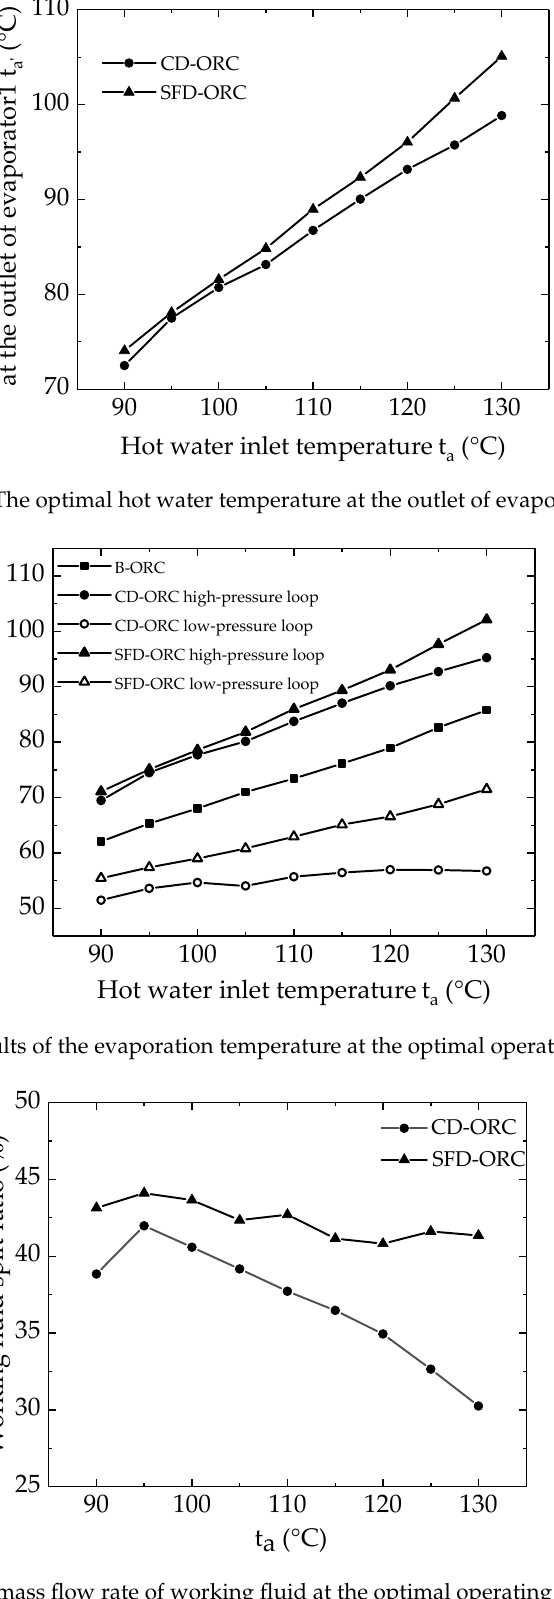
Figure 13. The mass flow rate of working fluid at the optimal operating